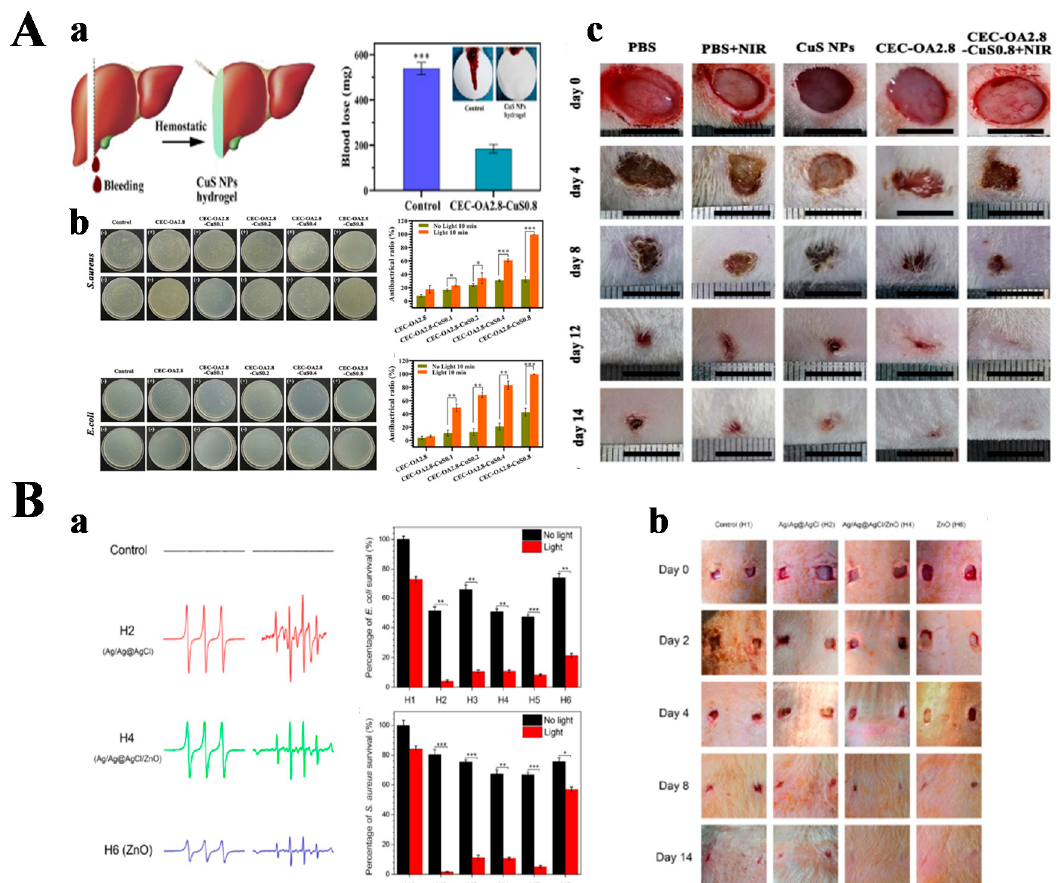
Figure 5. Inorganic antibacterial agent hydrogel for wound healing. ( A ) The CuS NP hydrogel. ( a ) Schematic diagram of preparation of a liver bleeding model and hemostatic property of CuS NP hydrogels; ( b ) antibacterial ability of CuS NP hydrogel; ( c ) in vivo healing evaluation of infected wounds. Statistically significant: * p < 0.05, ** p < 0.01, and *** p < 0.001. Reprinted with permission from Ref. [97]. Copyright 2021, American Chemical Society. ( B ) The Ag/Ag@AgCl/ZnO nanocom-